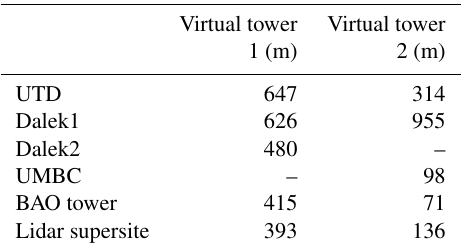
Table 2. Distance of the four scanning Doppler wind lidars from their respective virtual